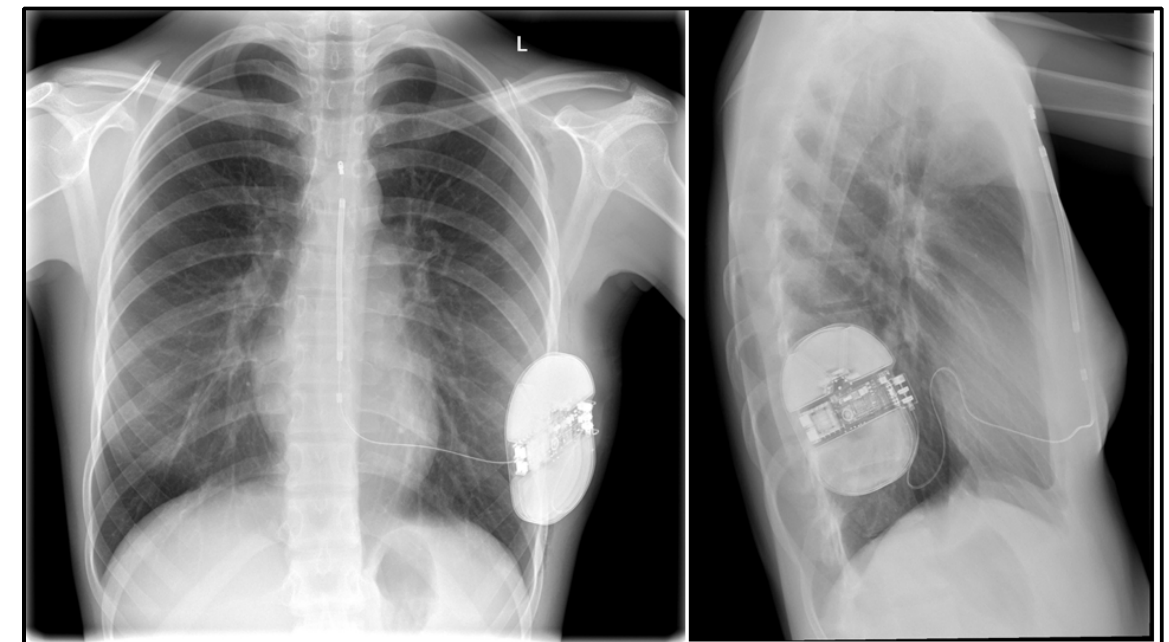
Figure 4. Patient 8. Chest radiograph of a slim female patient.